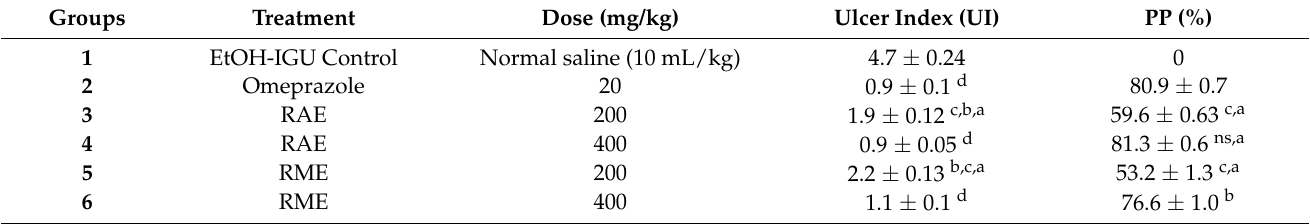
Figure 4. Macroscopic morphology of mice stomachs in ethanol-induced gastric damage model (H&E stain × 100). ( A ) Normal control ( B ) ethanol-control, ( C ) omeprazole (20 mg/kg), ( D ) RAE (200 mg/kg), ( E ) RAE (400 mg/kg), ( F ) RME (200 mg/kg), ( G ) RME (400 mg/kg). Table 5. Anti ‐ ulcerogenic activity of R. tuberculata polar extracts on ethanol ‐ induced ulcers in mice.